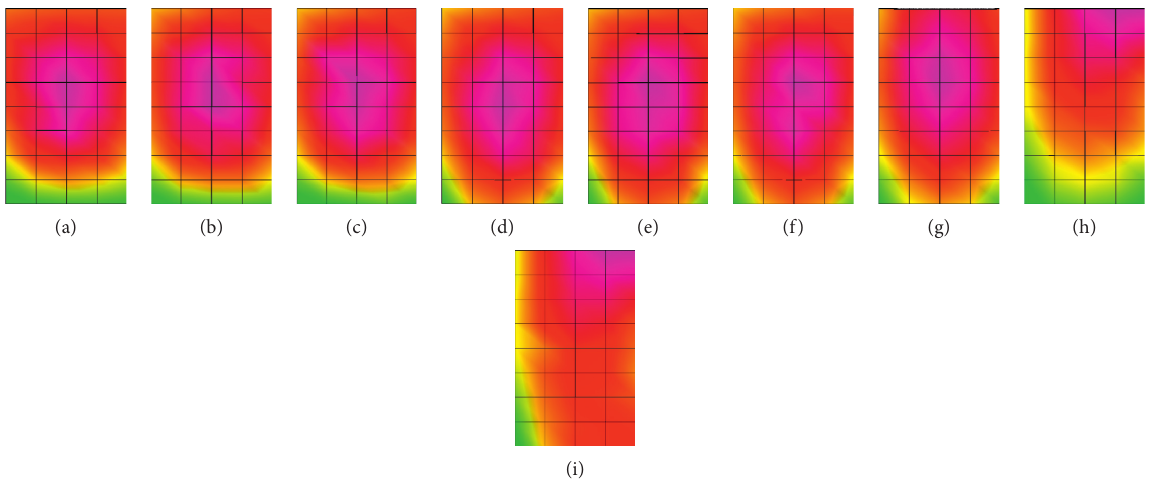
Figure 15: First mode shapes for various cases: (a) Case 1; (b) Case 2; (c) Case 3; (d) Case 4; (e) Case 5; (f) Case 6; (g) Case 7; (h) Case 8; (i) Case